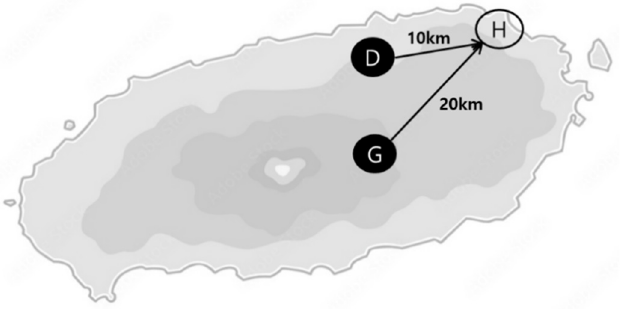
Figure 12. Transmission of curtailment from neighbor wind farms to “H” wind farm. Table 30. Annual curtailment record for “H” and neighbor wind farms [4,28]. Wind Farm